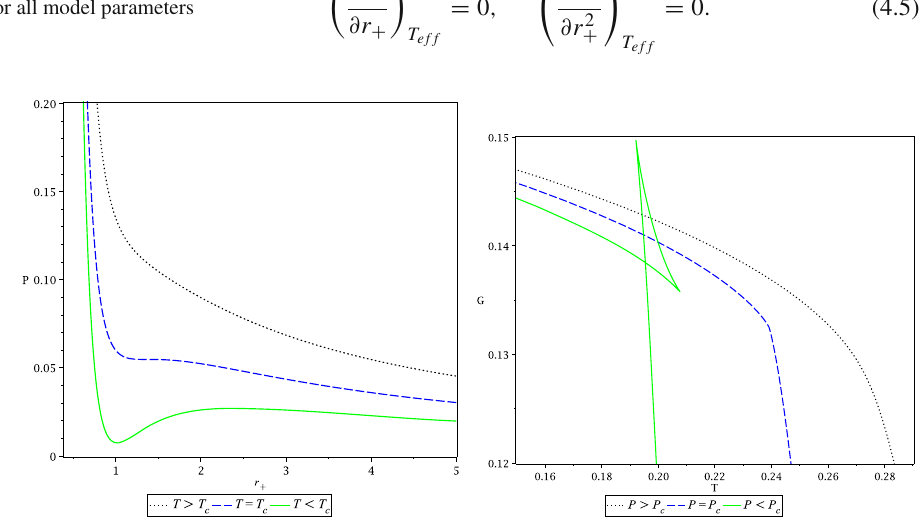
Fig. 10 Typical behavior of the specific heat in terms of ε in the third model (Eq. (3.23)), with unit value for all model parameters